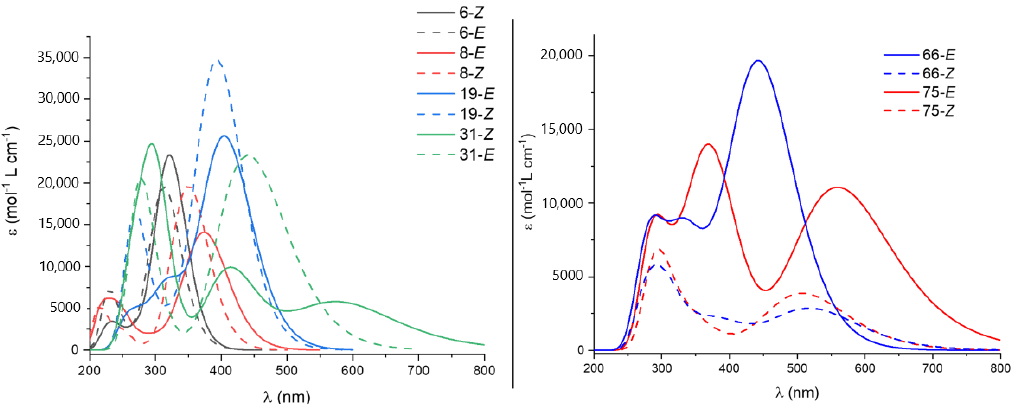
Figure 8. UV-Vis spectra for selected compounds of ( left ) different types of photoswitches ( 6 , 8 , 19 and 31 ) and ( right ) azoheteroarenes ( 66 and 75 ).